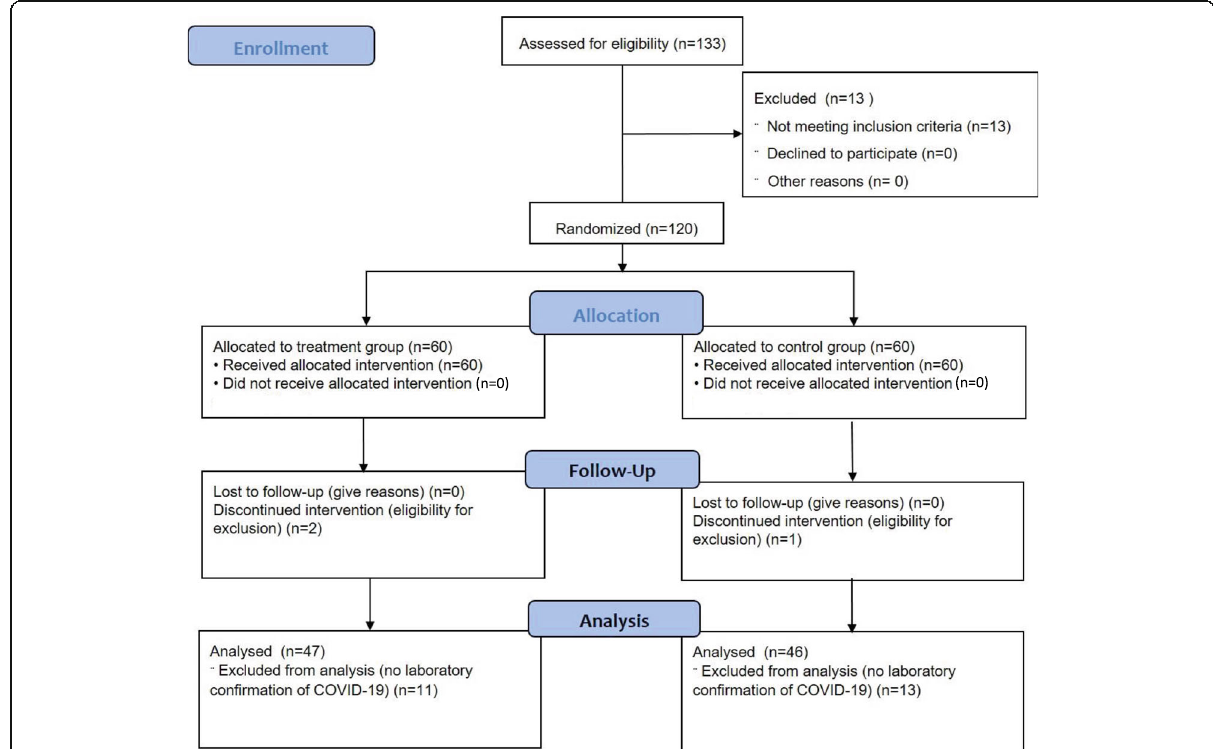
Fig. 1 CONSORT diagram: patients included in screening and randomization and excluded from the study